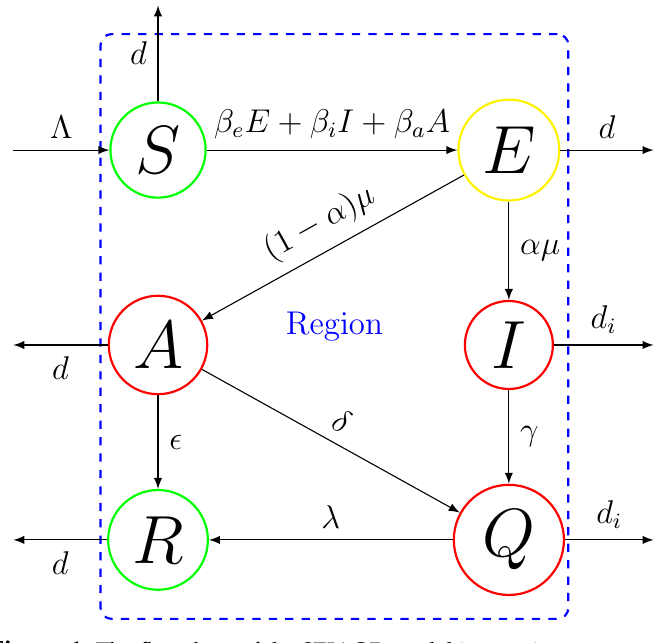
Figure 1. The flowchart of the SEIAQR model in a